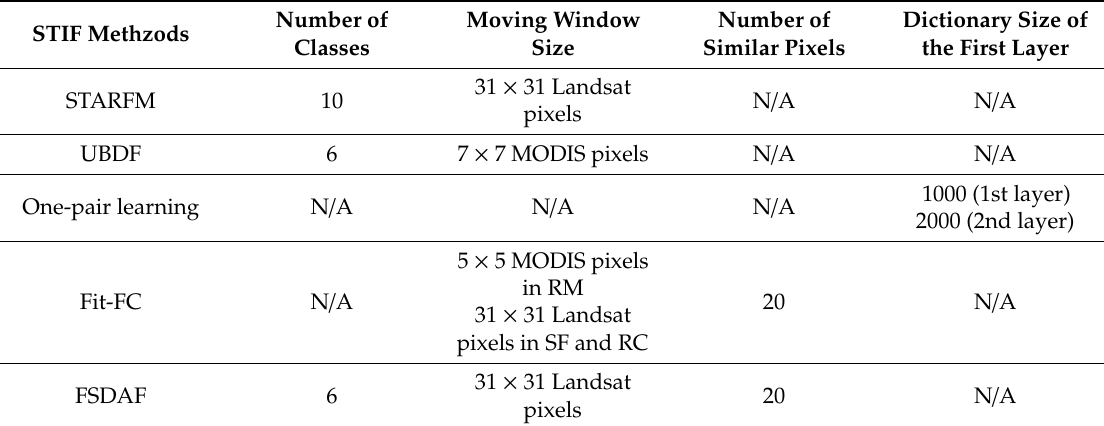
Table 2. Parameters of the five methods based on empirical